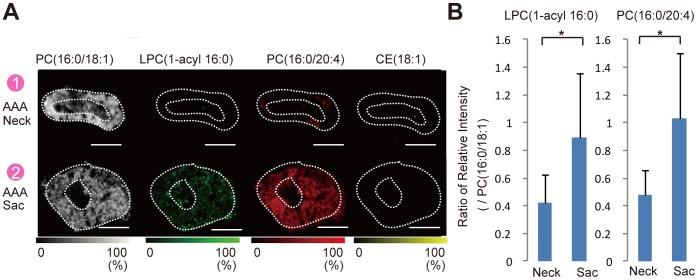
Distribution of lipid molecules in VV in high resolution.(A) MALDI-IMS. Comparison of the distribution of lipid molecules, phosphatidylcholine (PC) (16∶0/18∶1), lyso-PC (LPC) (1-acyl 16∶0), PC(16∶0/20∶4), and cholesteryl ester (CE) (18∶1), in the VV wall between the neck and sac regions analyzed by matrix-assisted laser desorption/ionization imaging mass spectrometry (MALDI-IMS). Scale bar = 20 μm. (B) Comparisons of the relative intensity of LPC(1-acyl 16∶0)/PC(16∶0/18∶1) and PC(16∶0/20∶4)/PC(16∶0/18∶1) in the VV wall between the neck and sac regions analyzed by MALDI-IMS. *P<0.001 indicates a statistically significant difference.